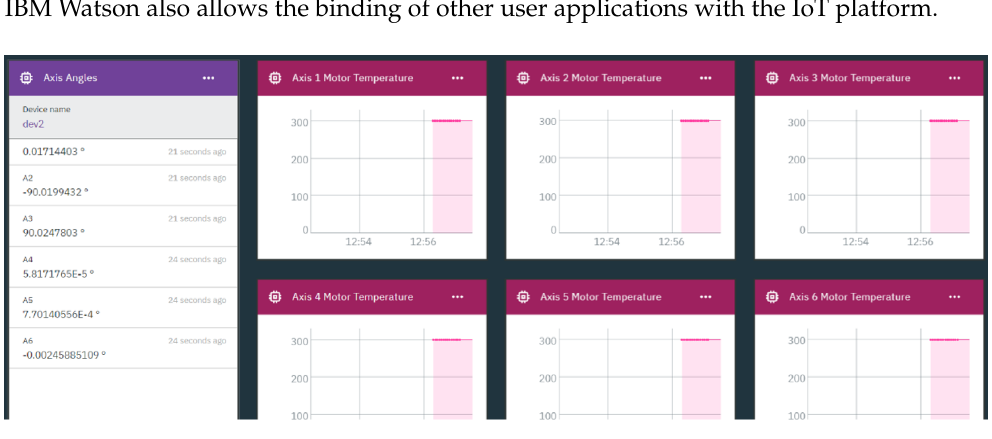
Figure 12. Data visualization in IBM Watson